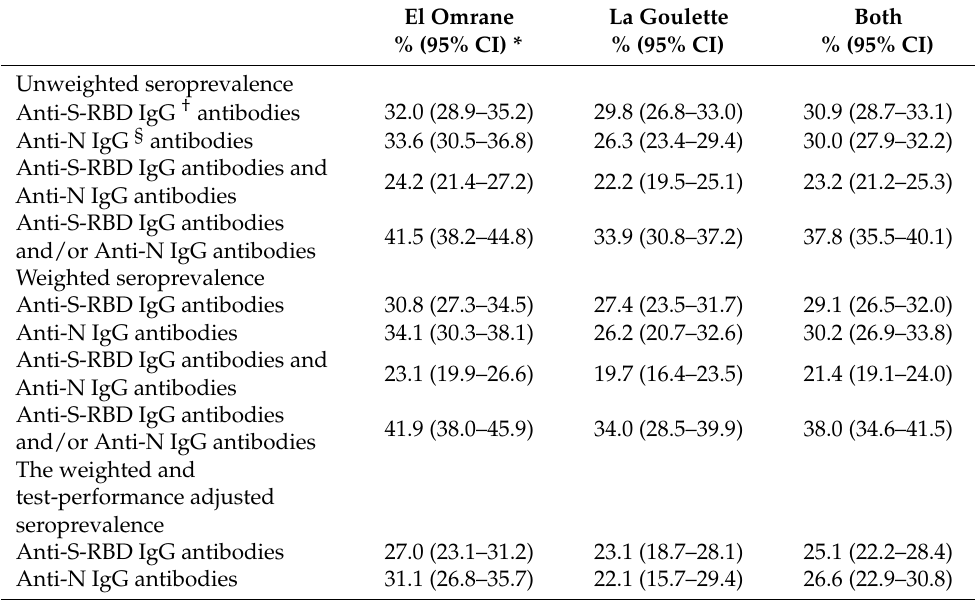
Table 2. Prevalence of Immunoglobulin G antibodies in the governorate of Tunis Tunisia.